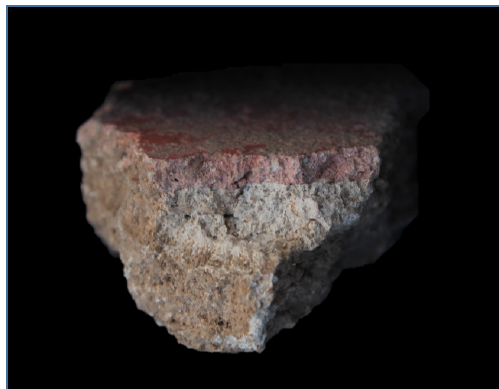
Figure 10. Wall painting fragment from the House of Orpheus. From top: dark red paint layer over a pink plaster layer, possibly a red ochre wash to increase the brilliance of the top red paint layer through light scattering, over a white plaster